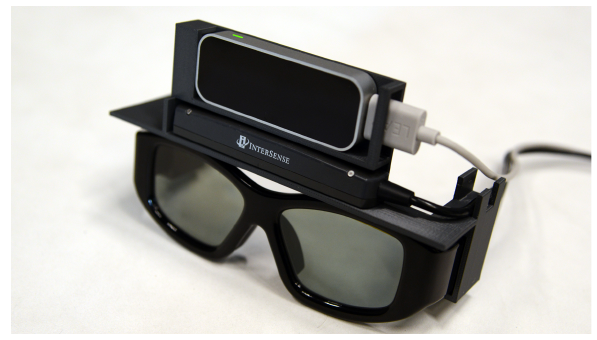
Figure 6. 3D glasses with the mounted leap-sensor